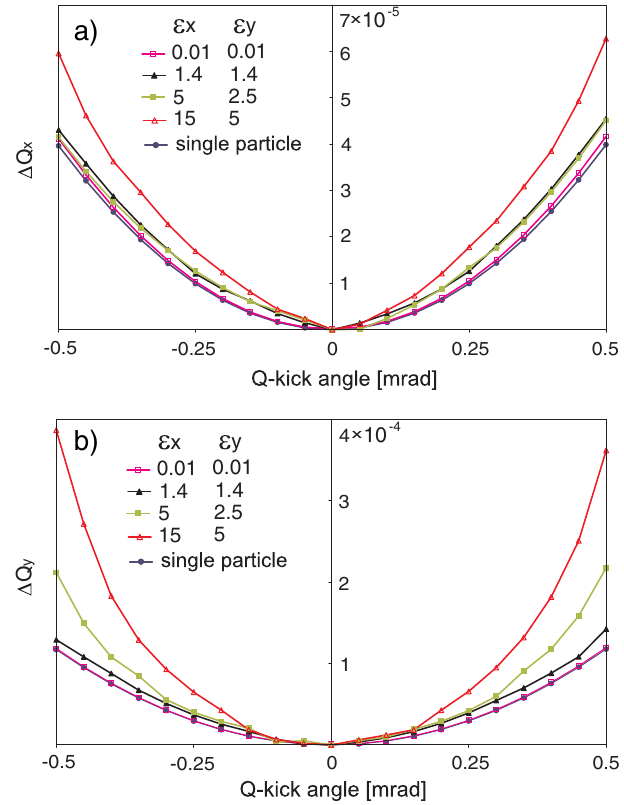
FIG. 4. (Color) Simulation dependence of the nonlinear tune in the horizontal plane (a) and vertical plane (b) as a function of the amplitude of the kicked beam and its